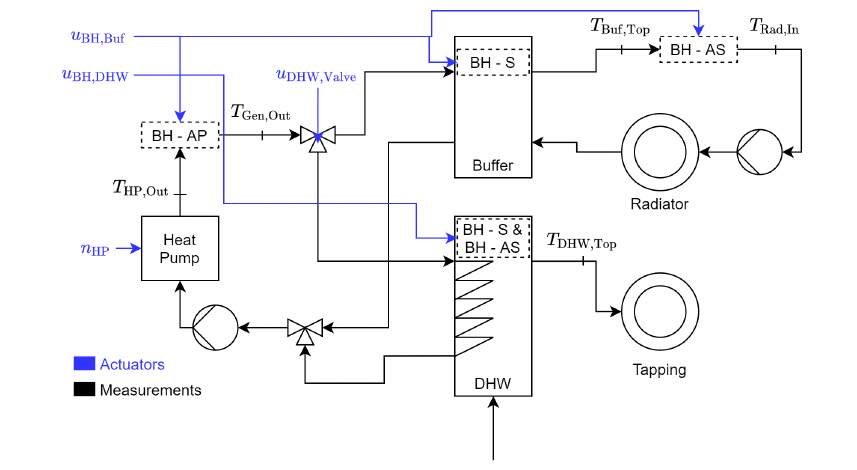
Figure 1. Three possible placements for BHs in parallel storage configuration according to [9,12,13]. After heat pump (BH-AP), inside the buffer storage (BH-S), and after the buffer storage (BH-AS). For the latter two, the BH is located in the DHW storage. Furthermore, control-relevant measurements points are stated.